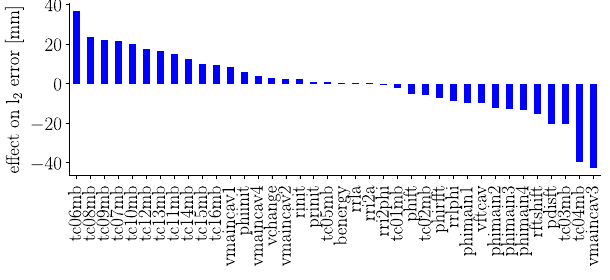
FIG. 20. Total effect during the local search on the l 2 error per design variable.